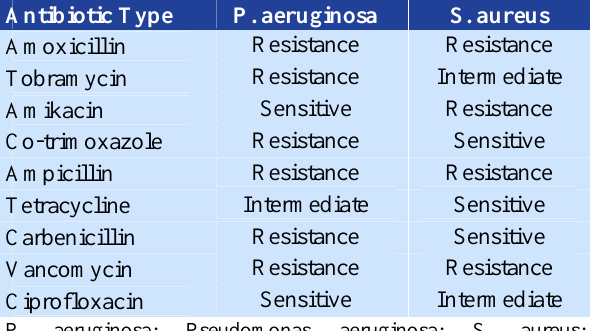
Table 2. Antibiotic resistance of isolated bacteria